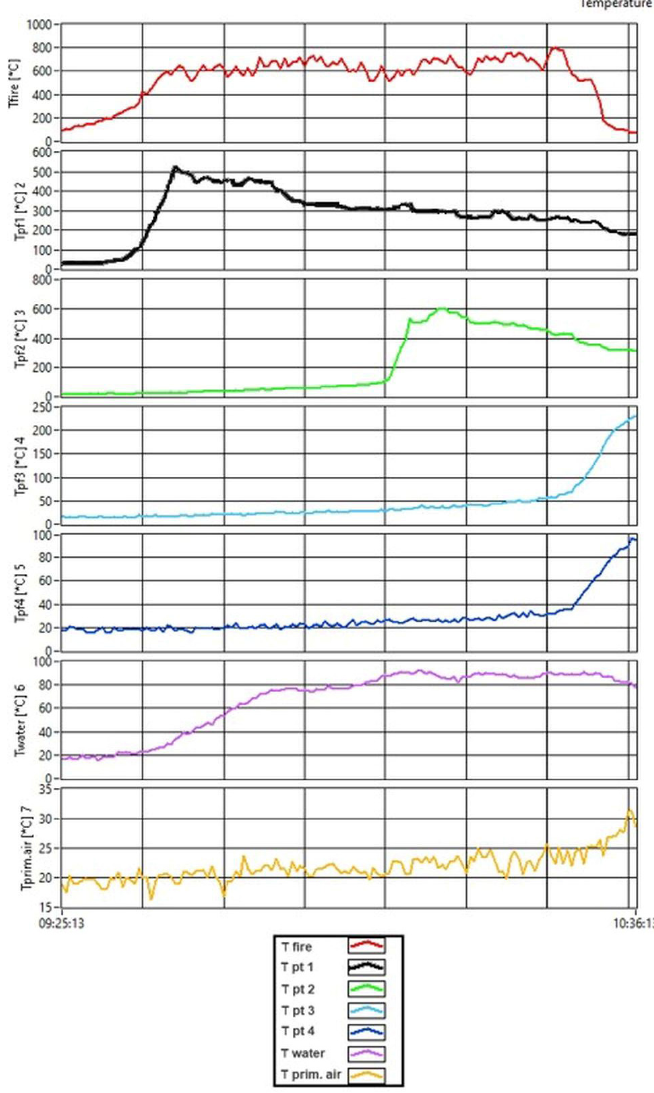
Figure 9. Evolution of temperatures acquired during the test with a ratio of 1/4 and a flow rate of 19/56 L/min.